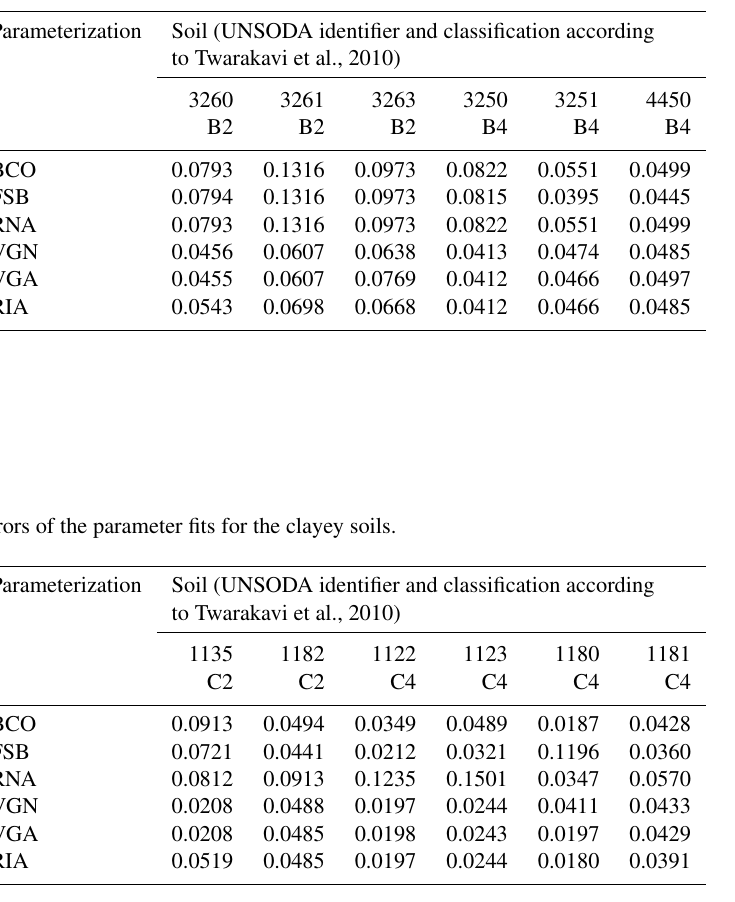
Table C7. Root mean square errors of the parameter fits for the silty soils.